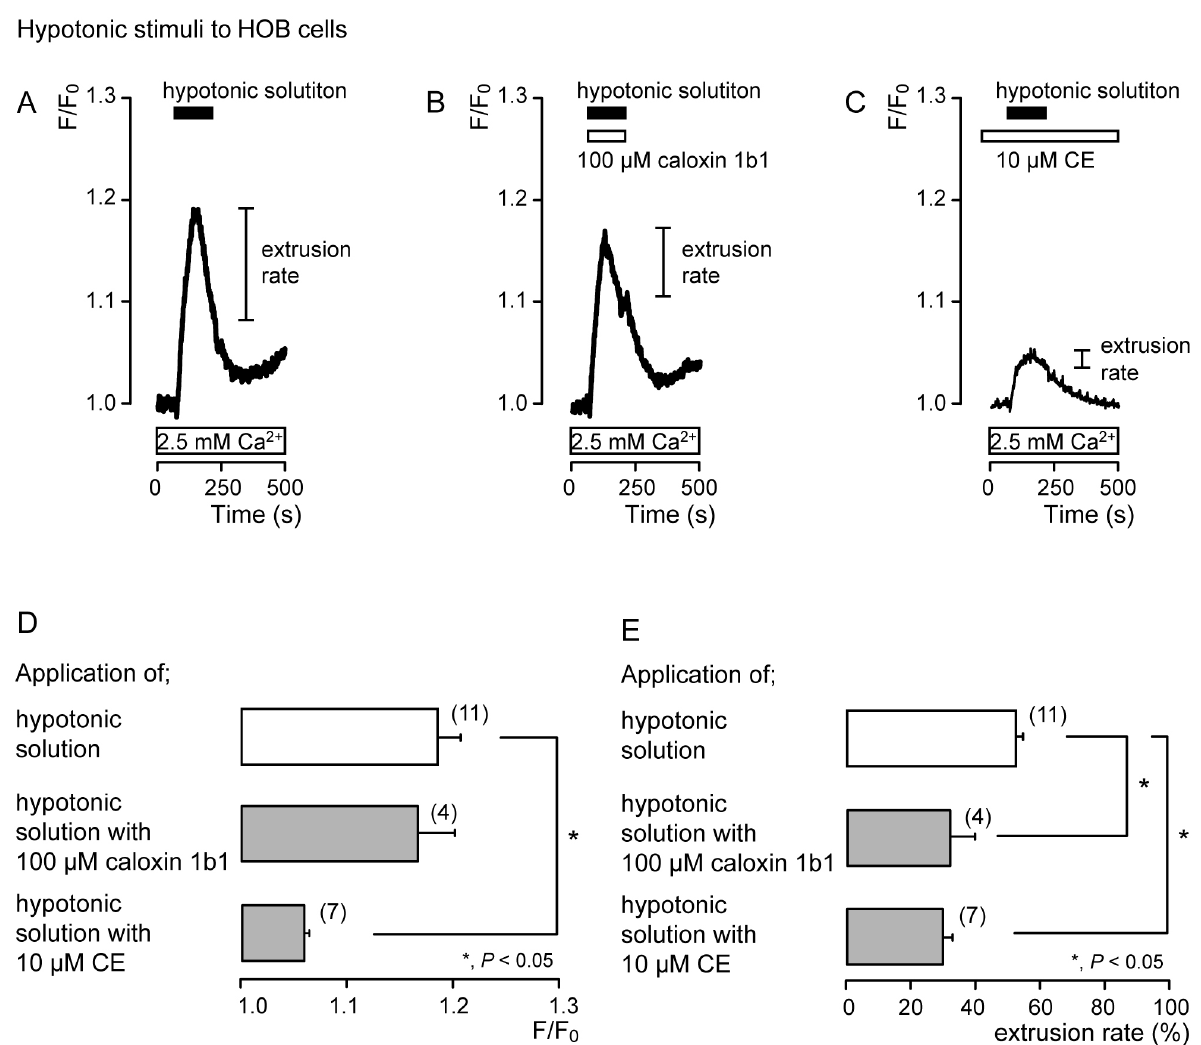
Figure 3. PMCA mediates Ca 2+ extrusion following hypotonic stimuli in HOB cells. ( A – C ) Representative traces of [Ca 2+ ] i following hypotonic stimuli (black boxes at tops of graphs) in the absence of 100 µ M caloxin 1b1 and 10 µ M CE ( A ), with 100 µ M caloxin 1b1 (white box at the top) ( B ), or with 10 µ M CE (white box at the top) ( C ), in the presence of extracellular Ca 2+ (white boxes at bottom in A to C). ( D ) Peak values of [Ca 2+ ] i during hypotonic stimuli without 100 µ M caloxin 1b1 and 10 µ M CE (open column; 1.19 ± 0.02 F/F 0 units), with 100 µ M caloxin 1b1 (upper gray column; 1.17 ± 0.03 F/F 0 units), and with 10 µ M CE (lower gray column; 1.06 ± 0.00 F/F 0 units). Each column denotes the mean ± SE from 11, 4, and 7 independent experiments, respectively. ( E ) Ca 2+ extrusion rates during hypotonic stimulation in the absence of 100 µ M caloxin 1b1 and 10 µ M CE (open column; 53.4 ± 2.2%), with 100 µ M caloxin 1b1 (upper gray column; 32.4 ± 7.3%), and with 10 µ M CE (lower gray column; 29.7 ± 3.0%). Each column denotes the mean ± SE from 11, 4, and 7 independent experiments, respectively. Statistically significant differences (in ( D , E )) between columns (shown by solid lines) are indicated by asterisks. * P <